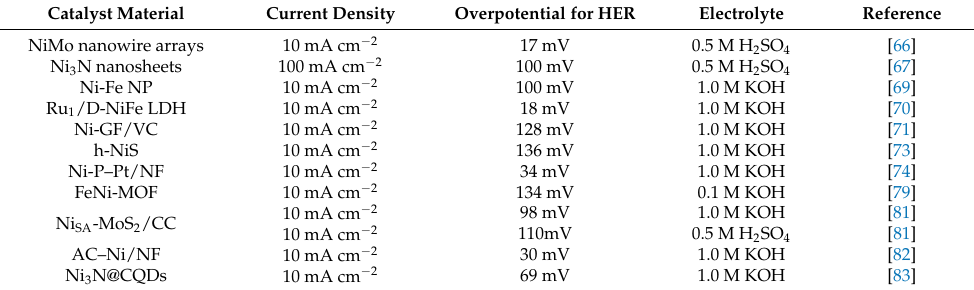
Table 2. Comparison of HER performance for Ni-based